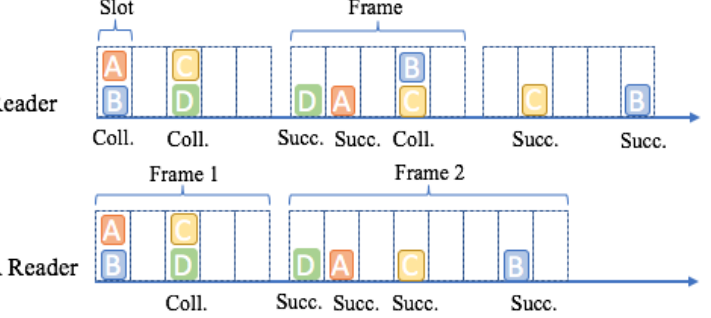
Figure 10. Example of FSA and